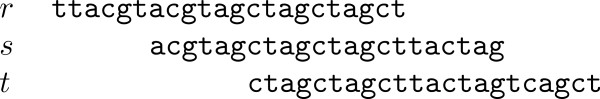
Example of a transitive suffix-prefix match. An example of a transitive SPM. A set of three reads with a transitive SPM 〈r, t, 10〉 derived from 〈s, t, 16〉.